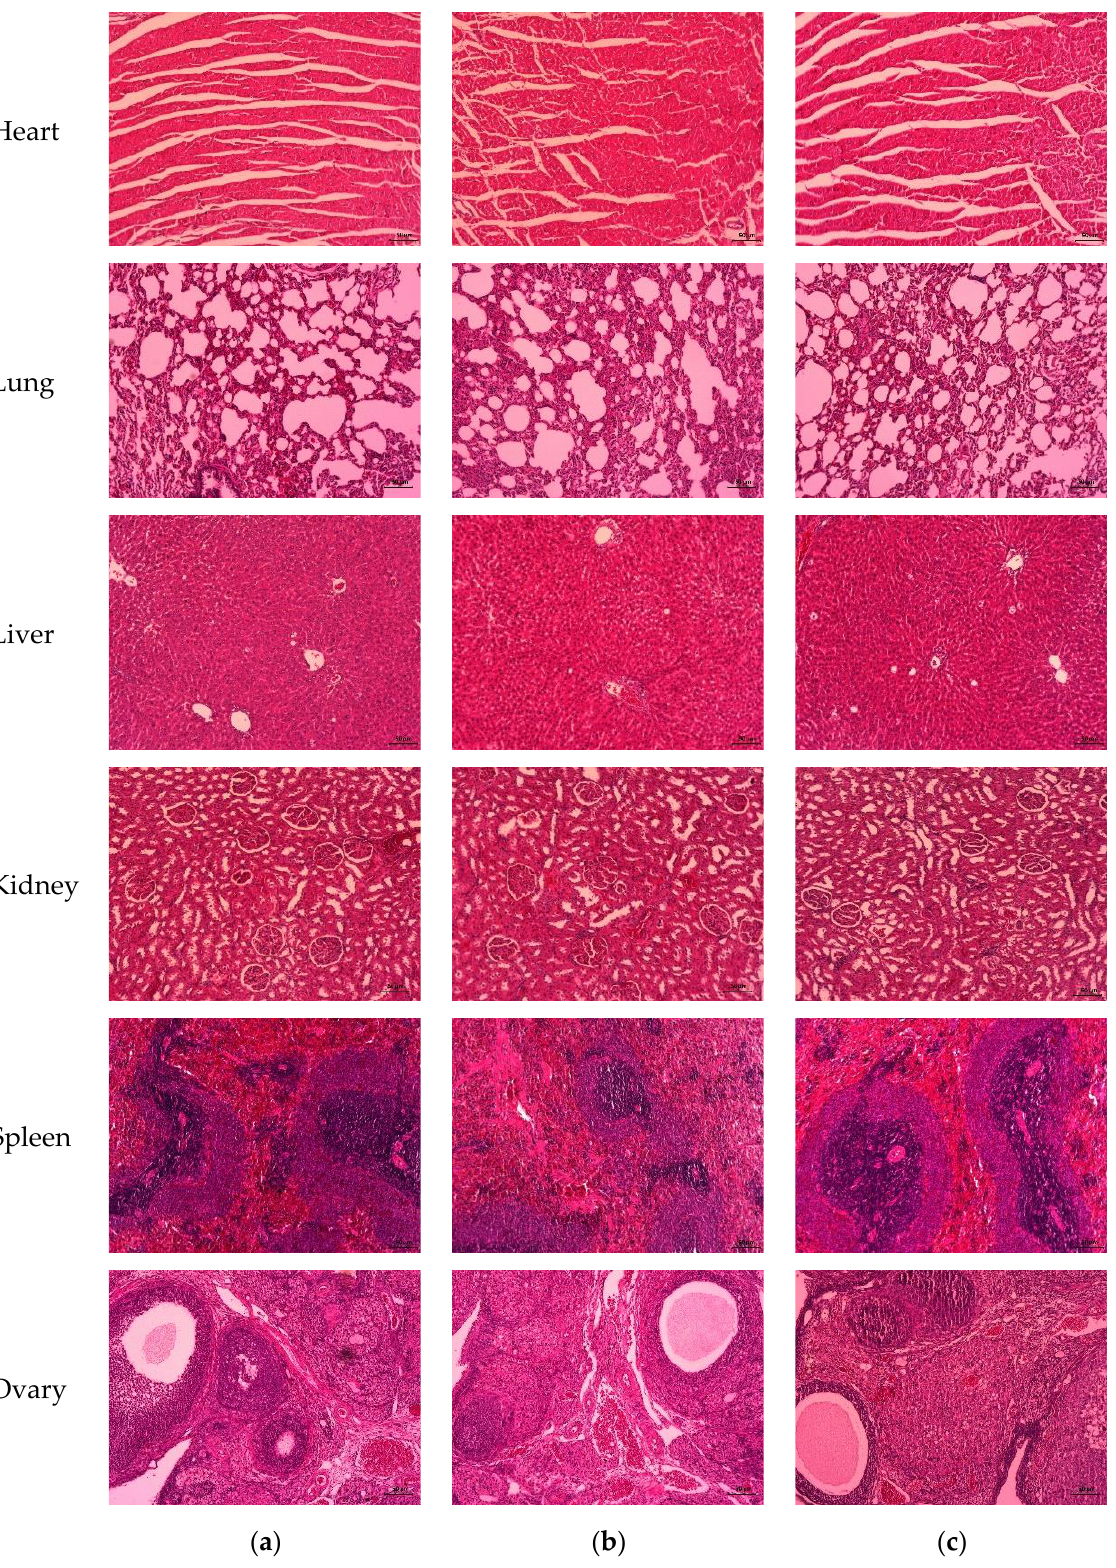
Figure 5. Histopathological analysis of the vital organs of female rats treated with distilled water ( a ), H-BSO ( b ), and L-BSO ( c ) for 28 days showed normal morphology (hematoxylin and eosin, magnification 10×). Scale bar = 50 μm.